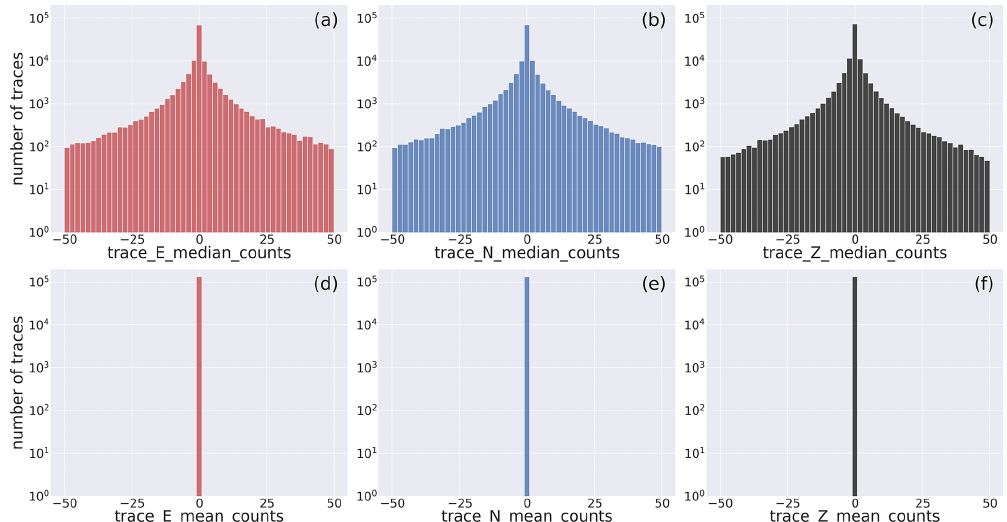
Figure 18. Close view of the histogram of the distribution of the median and mean values of the E -, N -, and Z -component noise waveform traces. The full distribution is shown in Fig. D5. Note that the mean values (d–f) are shown to the sole scope of reference. The metadata names listed in Table 2 are used as labels for the specific metadata being